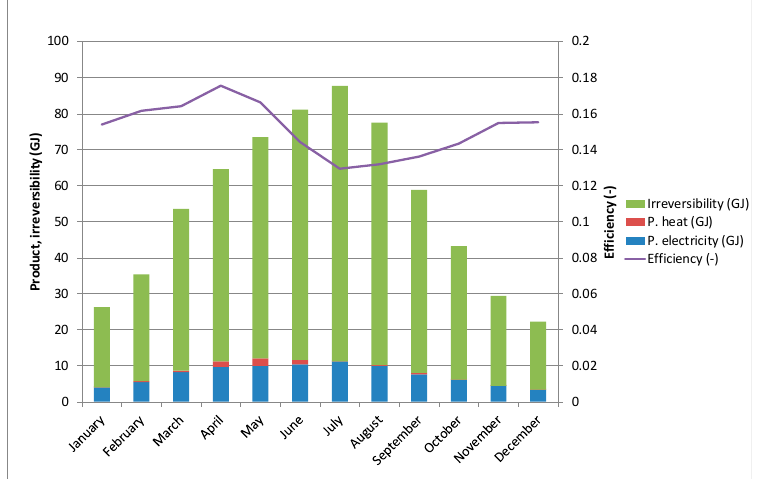
Figure 8. PVT: Product, irreversibility, and efficiency.